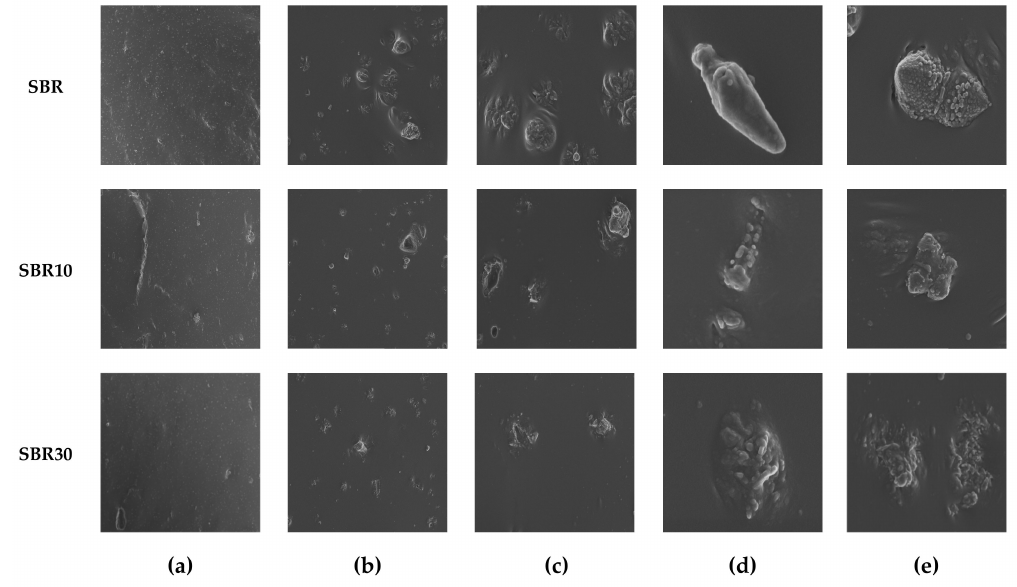
Figure 7. SEM images of SBR, SBR10, and SBR30 composites at di ff erent magnifications: ( a ) 1.00 × , ( b ) 10.00 × , ( c ) 25.00 × , ( d ) 50.00 × , and ( e ) 100.00 ×